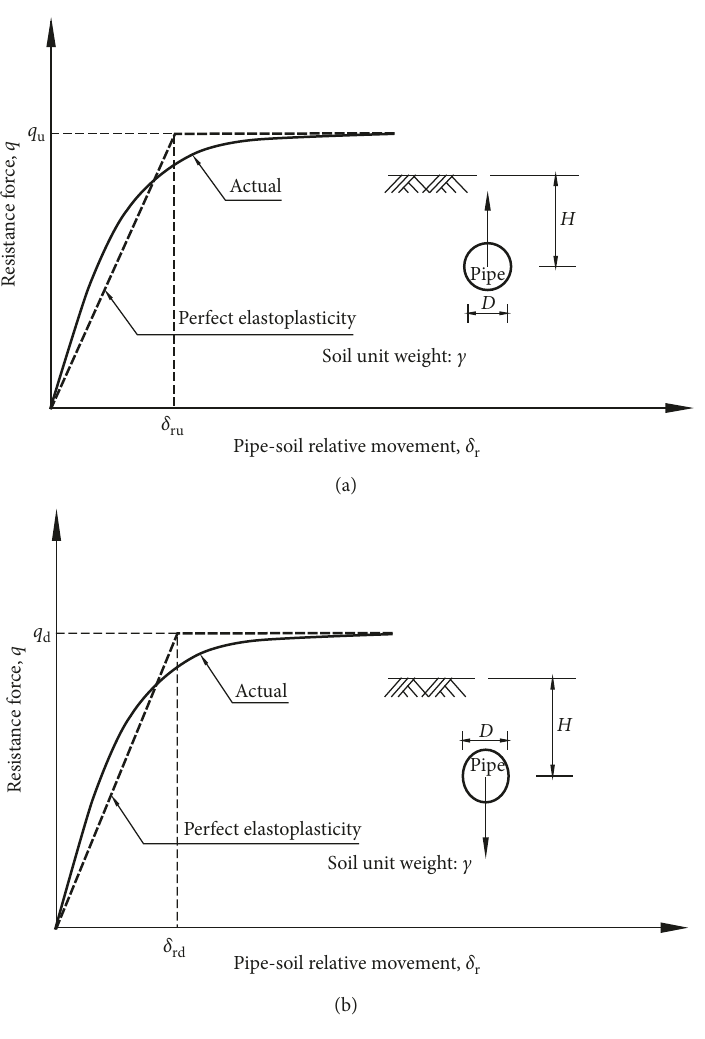
Figure 1: Force-displacement response in pipe-soil interaction. (a) Upward relative movement of the pipe versus the soil. (b) Downward relative movement of the pipe versus the soil.